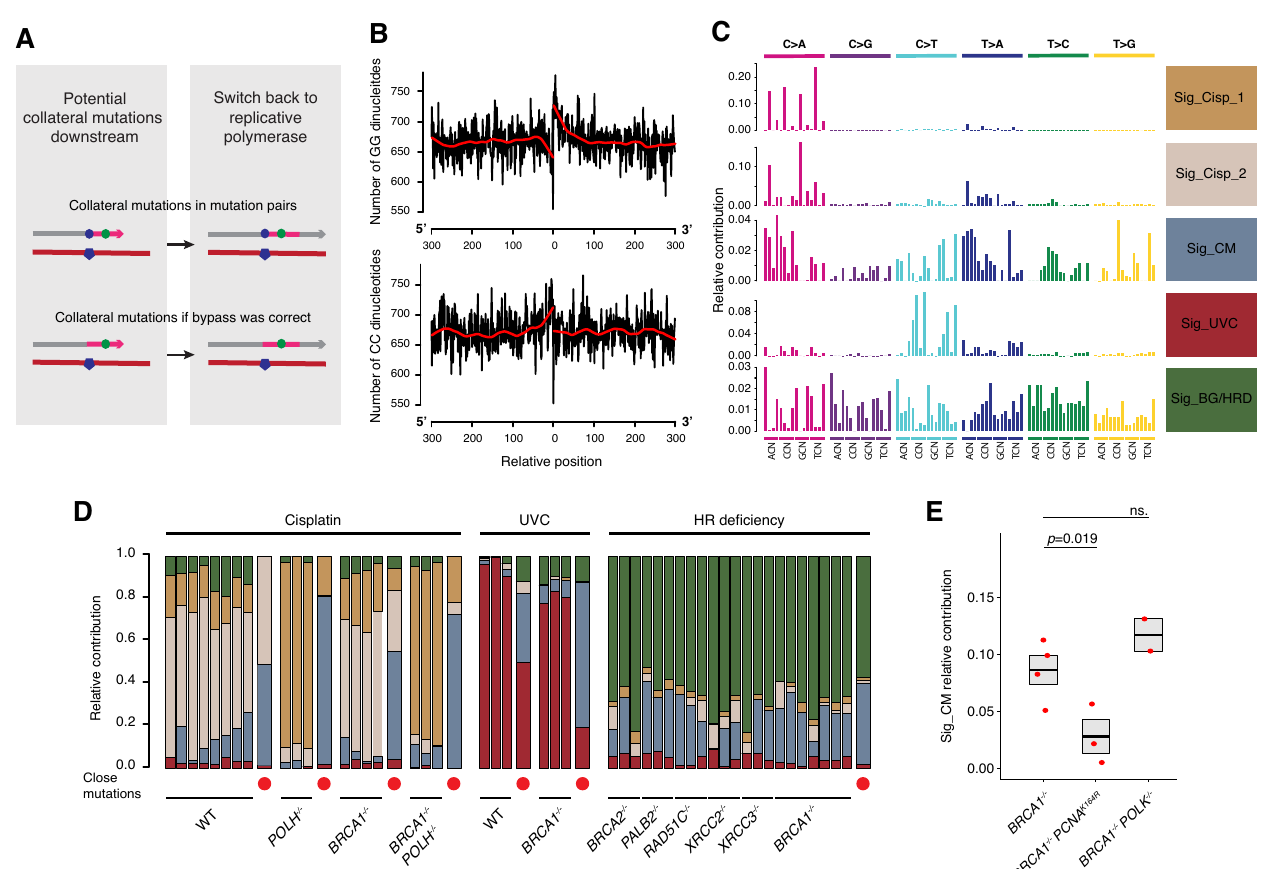
Fig 5. Collateral mutagenesis greatly contributes to overall mutational burden. (A) Scheme of solitary collateral mutations. Collateral mutations can occur in pairs with primary events during erroneous bypass (upper row) or downstream of correctly bypassed lesions (bottom row). (B) Occurrences of CC and GG dinucleotides around non-primary, solitary mutations in all cisplatin treated DT40 samples show an overrepresentation of potential lesion sites. The black lines connect dinucleotide counts in each position in a +/- 300 bps window, with lowess smoothing indicated in red. (C) The five components identified by de novo NMF on cisplatin-treated, UVC-treated and HR-deficient DT40 samples with mutations in close pairs treated as separate samples. (D) Relative contributions of the components in panel (C). Mutations in close pairs, denoted by red dots and wider columns, were separated in each genotype-treatment interaction, and treated as a distinct sample. (E) Contribution of Sig_CM to the mutation sets of cisplatin-treated samples of the indicated genotypes deconstructed using Sig_Cisp_1, Sig_Cisp_2, Sig_CM and Sig_BG/HRD. Statistical significance is indicated (two-sided unpaired t